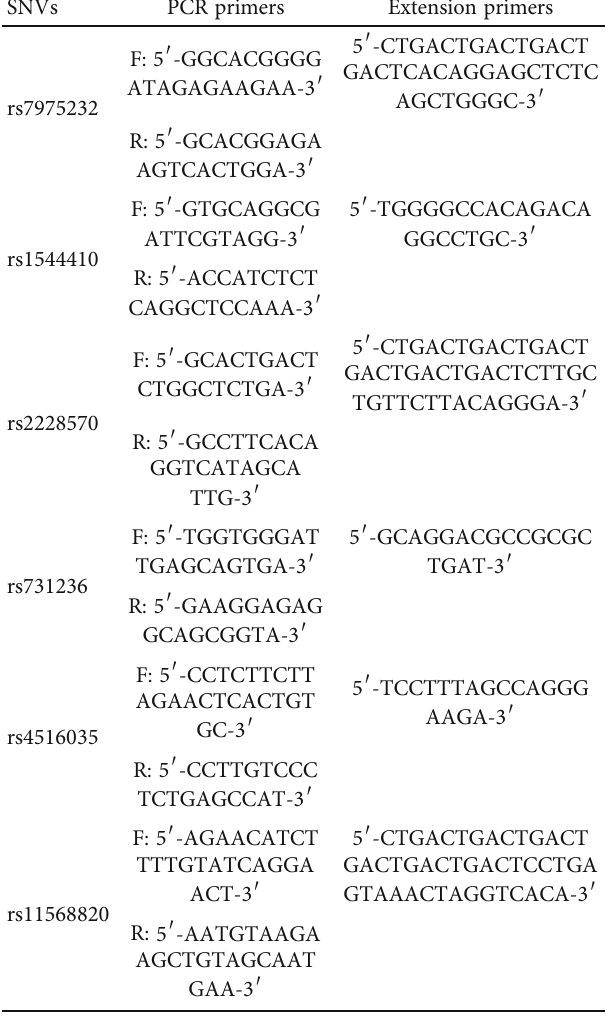
Table 2: Clinical characteristics of the FRI patients included. Clinical